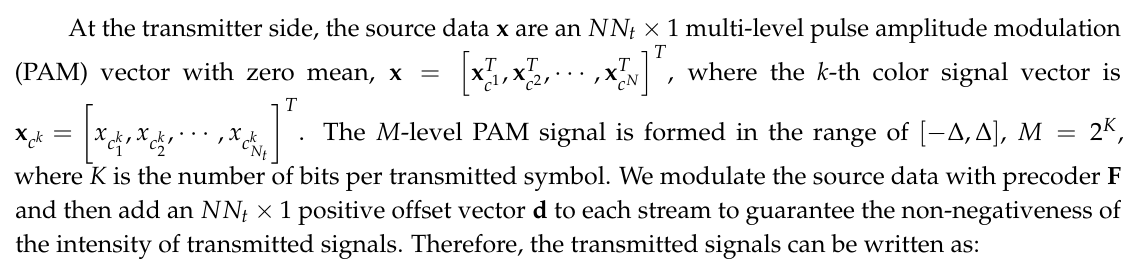
Figure 1. The system model of MIMO VLC using multi-color